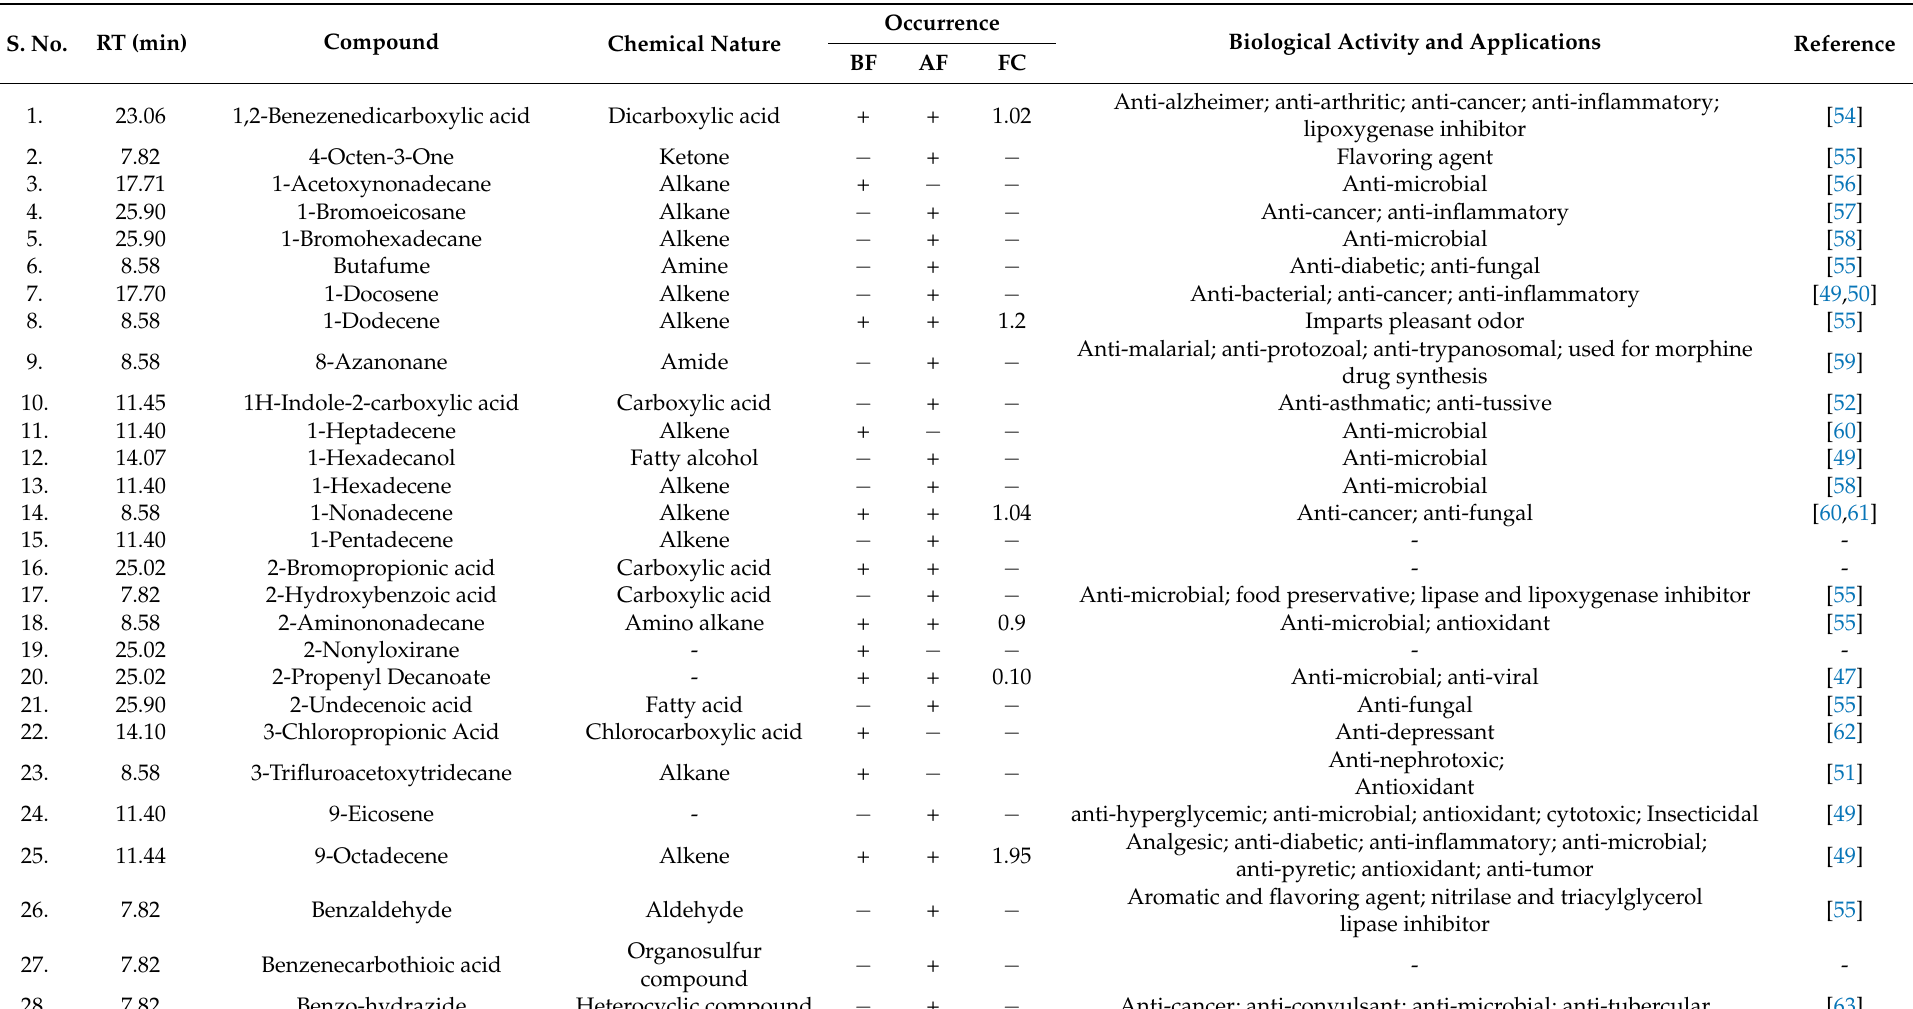
Table 2. GC-MS-based metabolomic fingerprint data of the functional buttermilk (manually integrated with previously reported biological